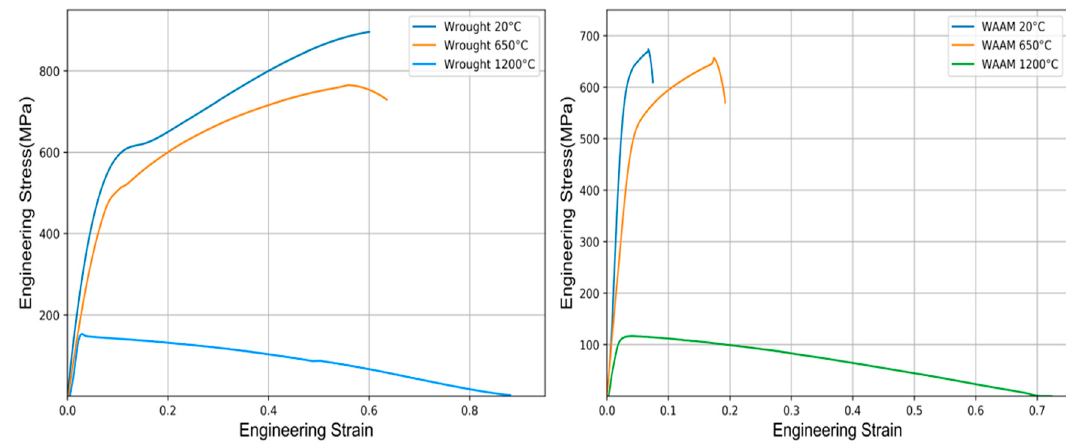
Figure 8. Engineering stress- strain curves of ( a ) Wrought ( b ) WAAM IN718 at elevated temperature.